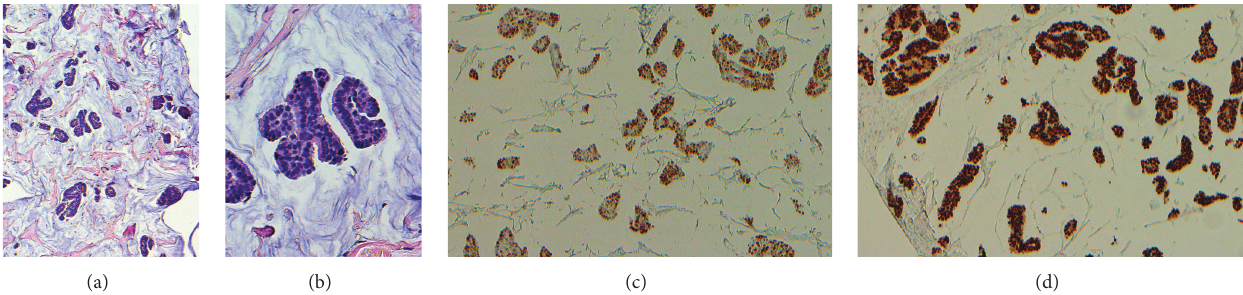
Figure 1: Colloid carcinoma of the breast. This invasive ducal carcinoma exhibits dominant mucin production and tumor cells are arranged in clusters and nests, floating in pools of extracellular mucin (a). Tumor cells are uniform in size and shape with hyperchromatic nuclei without prominent nucleoli and mitosis (b). PR (c) and ER (d) are positive in tumor cells. [(a) H&E, × 100; (b) H&E, × 400; (c) IHC, × 100; (d) IHC, × 100.]